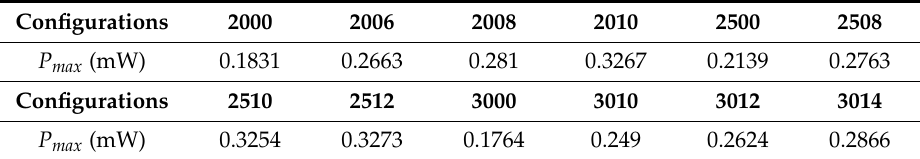
Table 3. P max of different configurations of the eccentric cylinder when b = 20